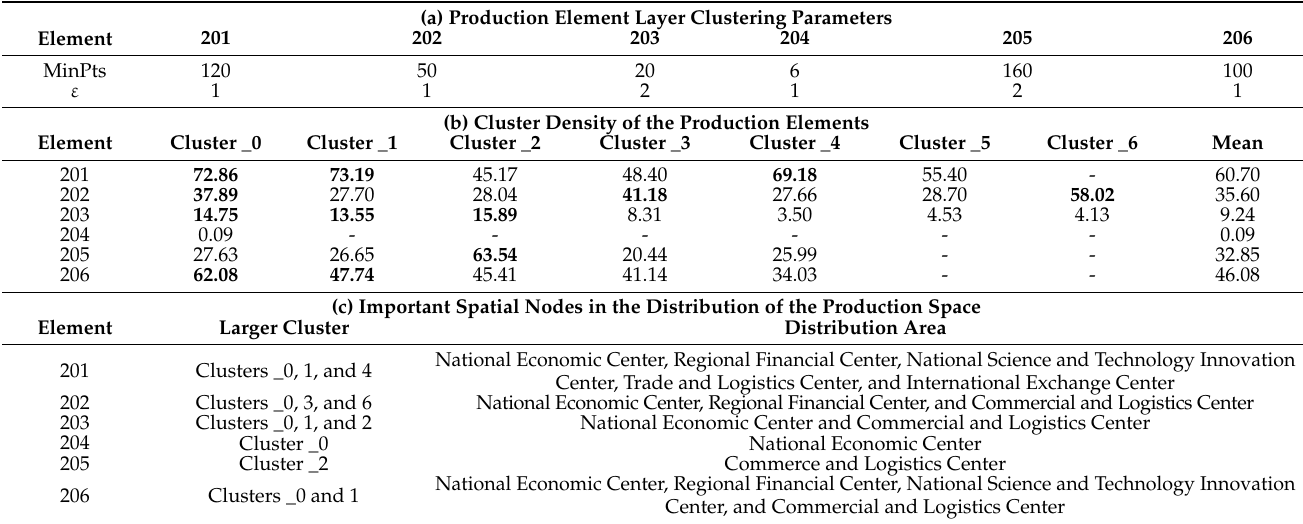
Table 5. Spatial distribution characteristics of production